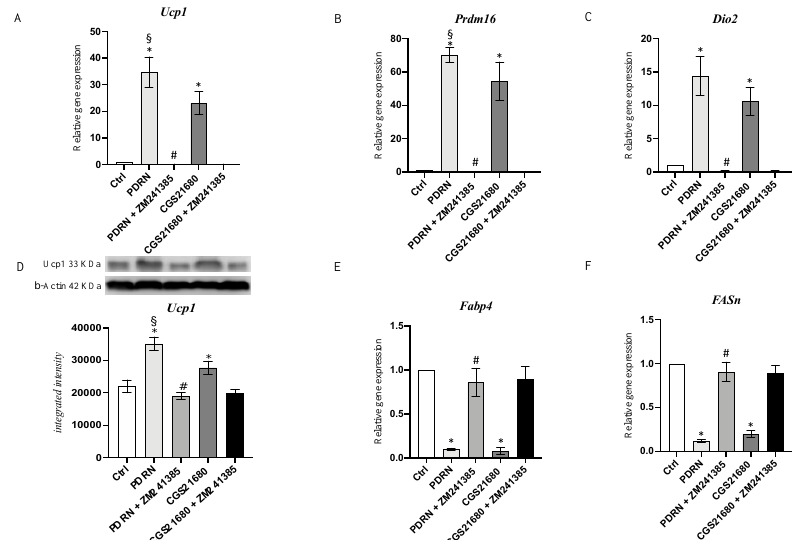
Figure 5. The graphs represent qPCR results of UCP1 ( A ), PRDM16 ( B ), DIO2 ( C ), FABP4 ( E ) and FASn ( F ) mRNA expression and protein levels of UCP1 ( D ) obtained from adipocytes cells. Values are expressed as the means and SD. N = 3 experiments; * p <0.0001 vs. CTRL; # p < 0.0001 vs. PDRN; § p < 0.001 vs. CGS21680.